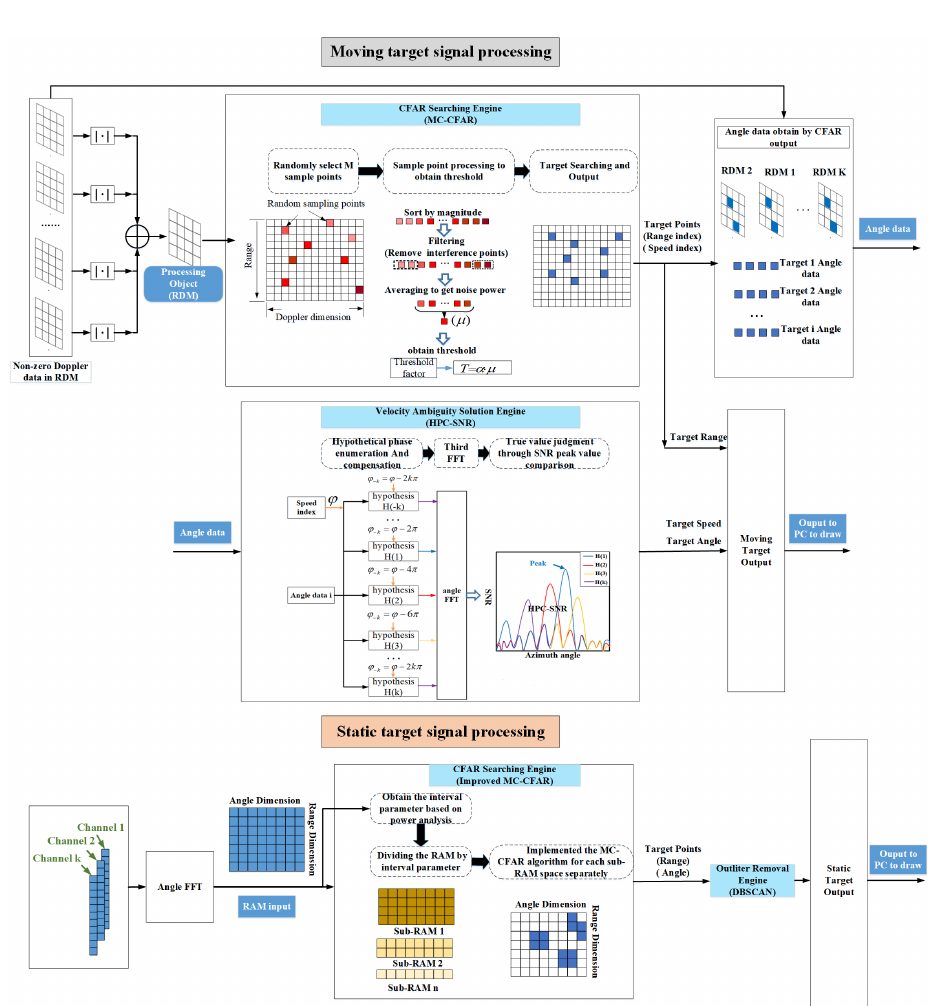
Figure A3. The radar signal post-processing